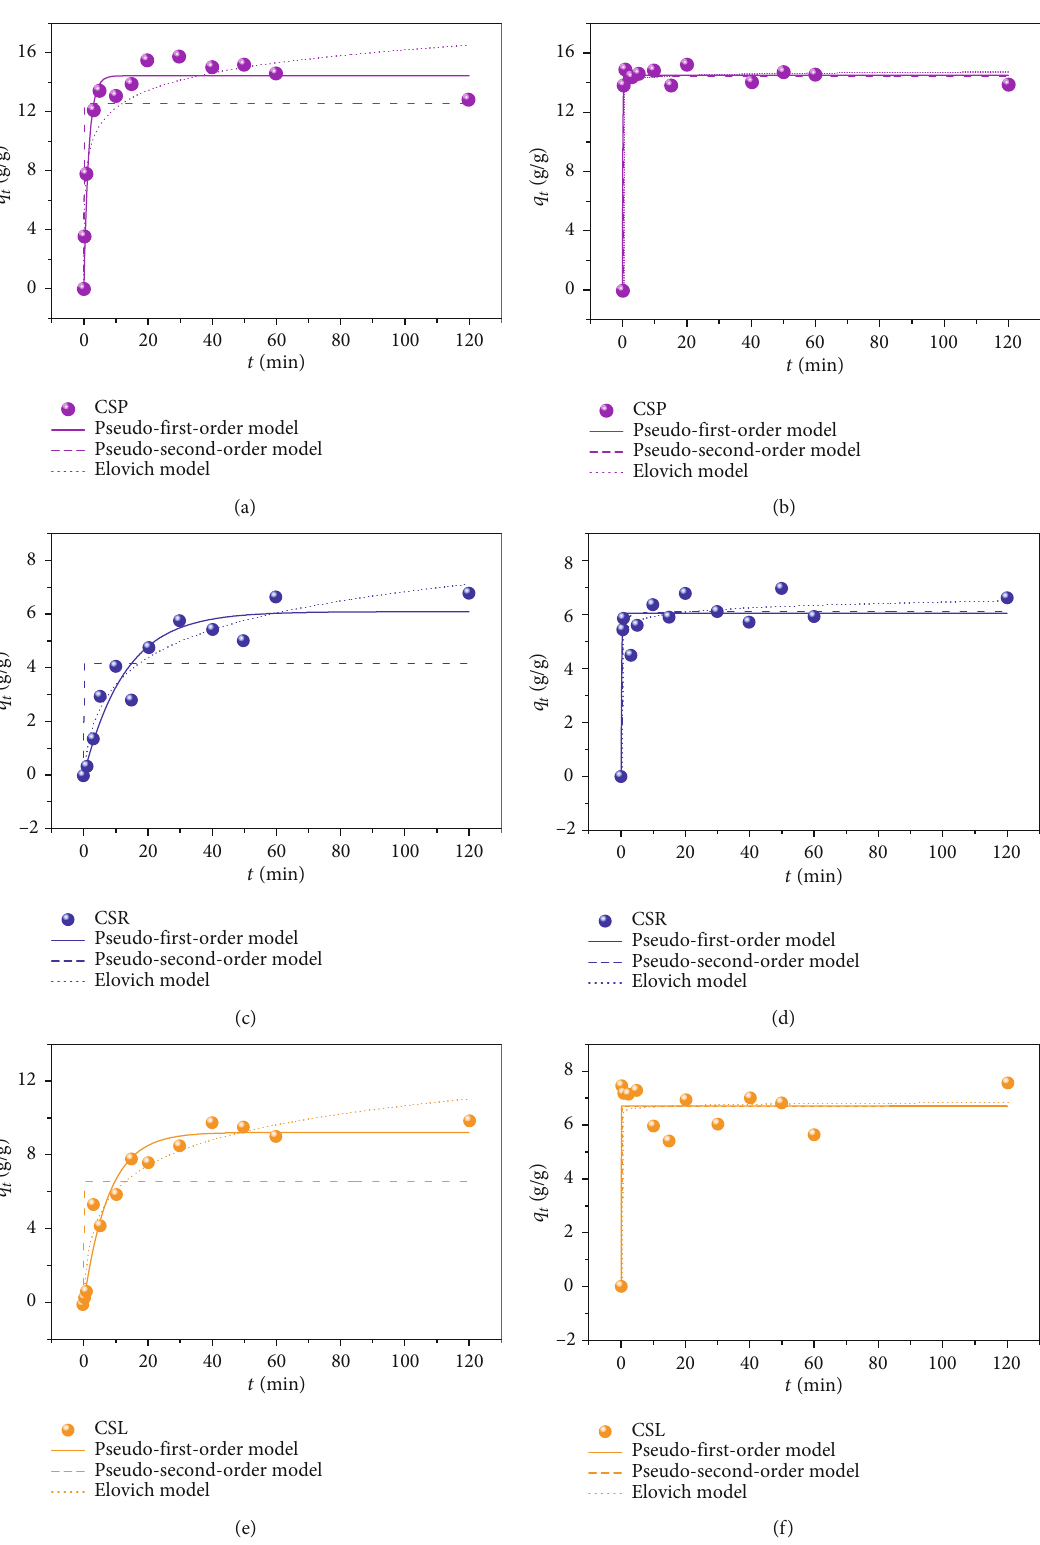
Figure 9: Adsorption kinetics for corn stover pith, rind, and leaf with oil-water solutions at low initial concentrations (a, c, e) and high initial concentrations (b, d,